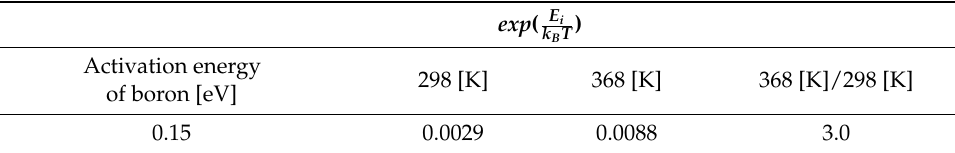
Figure 2. I DS - V DS characteristics at room temperature to 95 ◦ C when using two types of gate electrodes. ( a – e ) and ( f – h ) use an Ag/AgCl electrode and vessel gate, respectively. Table 1. Comparison of exponential term values when the activation energy of boron is 0.15 eV. As a result, it is considered that the channel conductance tripled when the activation energy of boron was 0.15